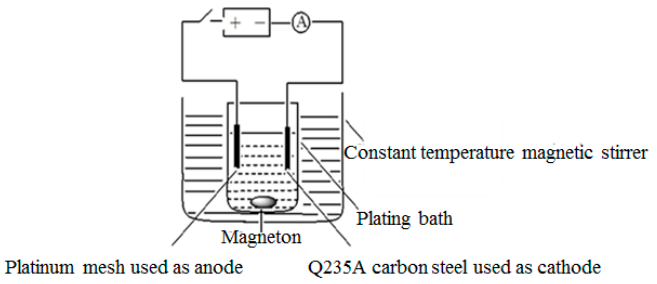
Figure 2. Schematic diagram of the Ni/nanodiamond composite plating device.